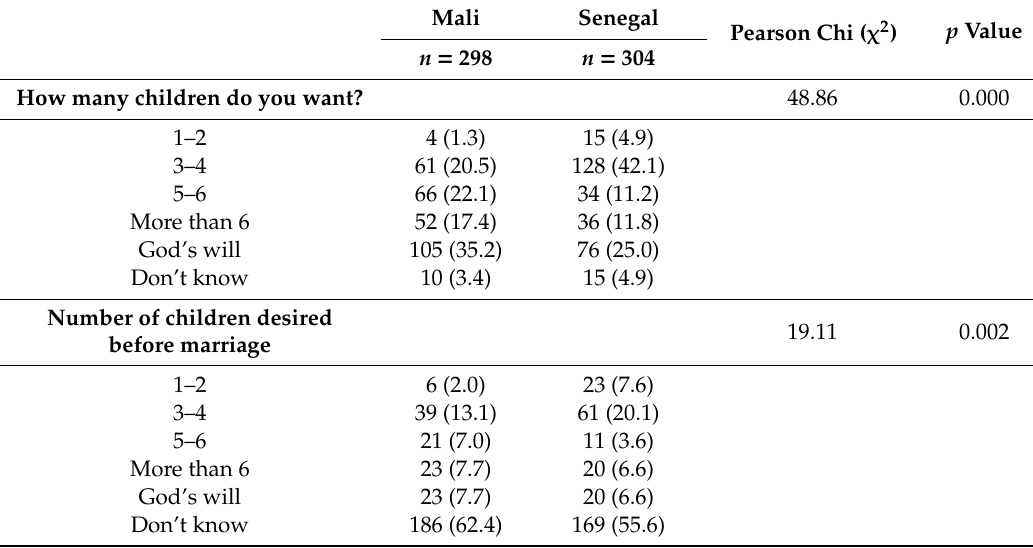
Table 3. Family size preference and family planning